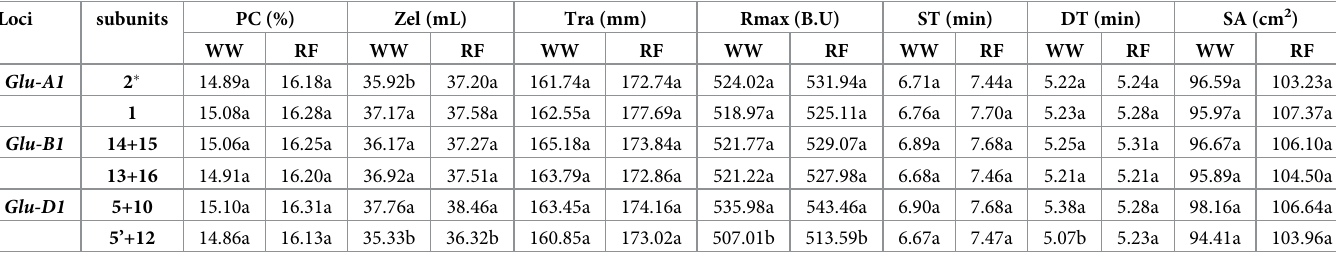
Table 4. Comparison of the effects produced by alleles at the Glu-1 loci on quality traits.